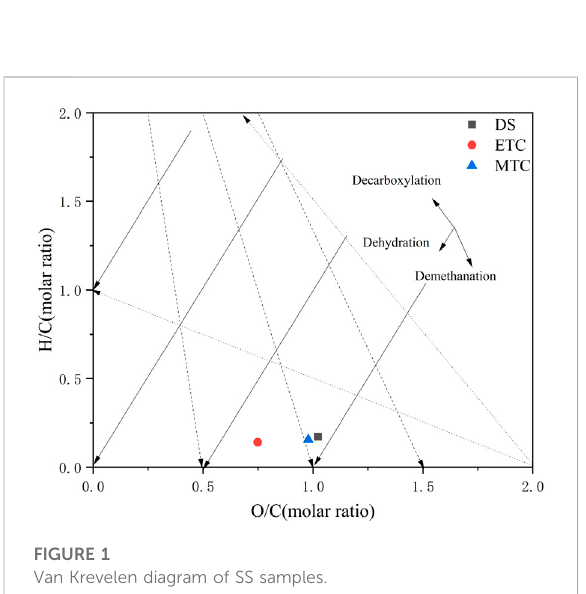
FIGURE 1 Van Krevelen diagram of SS